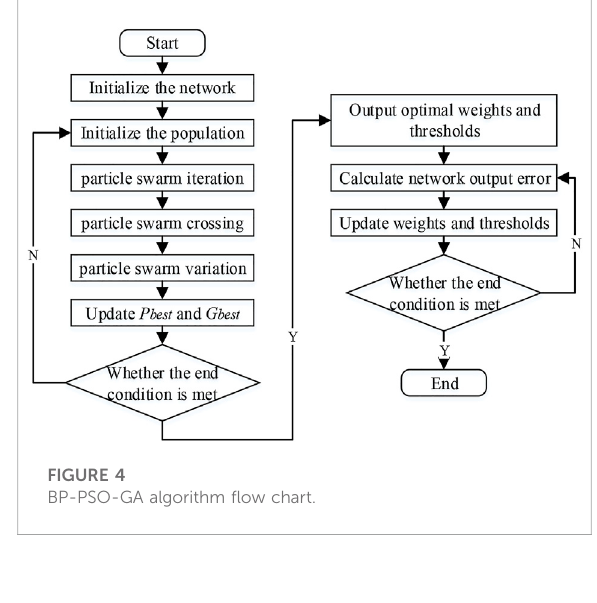
FIGURE 4 BP-PSO-GA algorithm fl ow